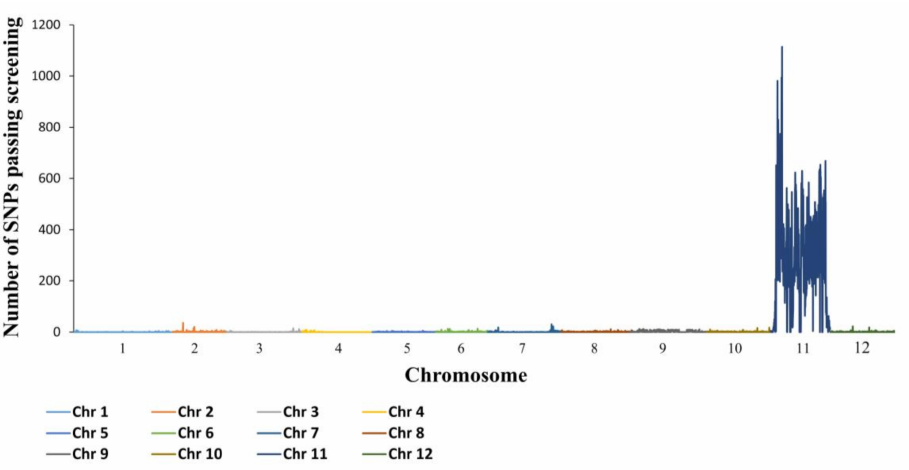
Figure 1. Mapping-by-sequencing of the gene controlling tolerance in VC532 [Each chromosome (Chr) is marked by a different